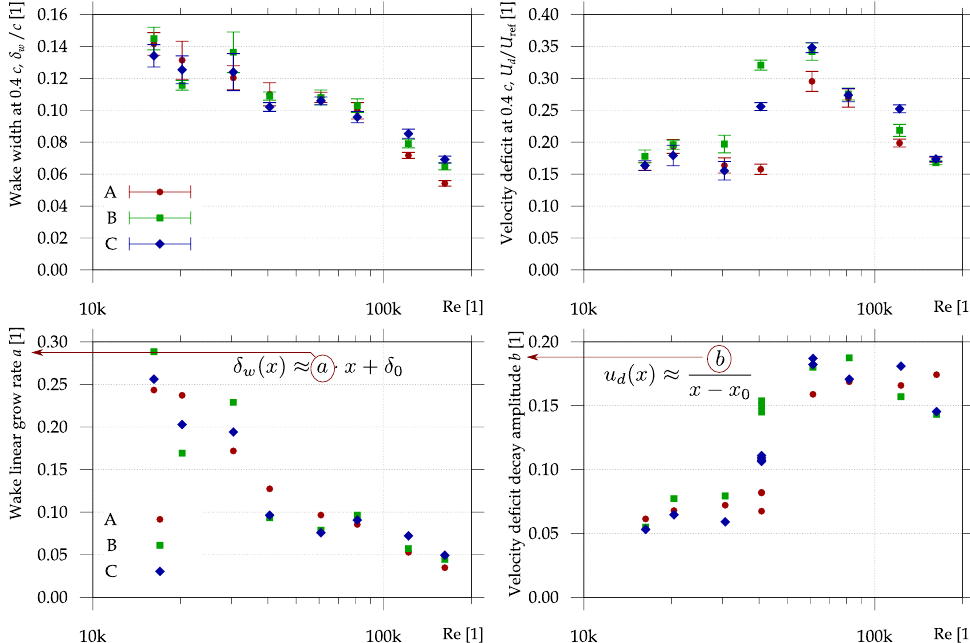
Figure 12. ( Top left ) Dependence of the wake width δ w at a fixed stream-wise distance x = 0.4 c past the trailing edge on the chord-based Reynolds number. ( Top right ) Dependence of the velocity deficit at a certain distance x = 0.4 c on the Reynolds number. ( Bottom left ) Dependence of the growth rate of the wake width a on the Reynolds number. ( Bottom right ) Decay rate of velocity deficit, if a hyperbolic decrease is expected. Angle of attack α = 0 ◦ in all panels.